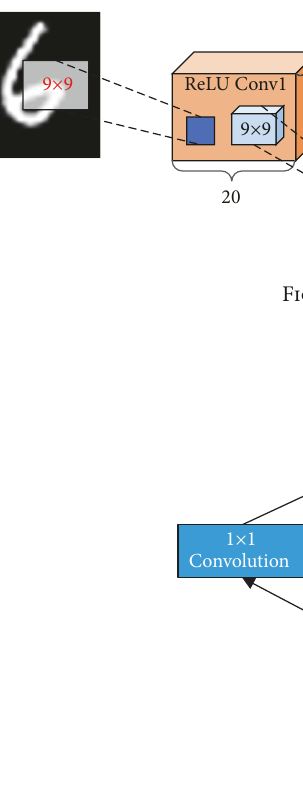
Figure 2: Inception